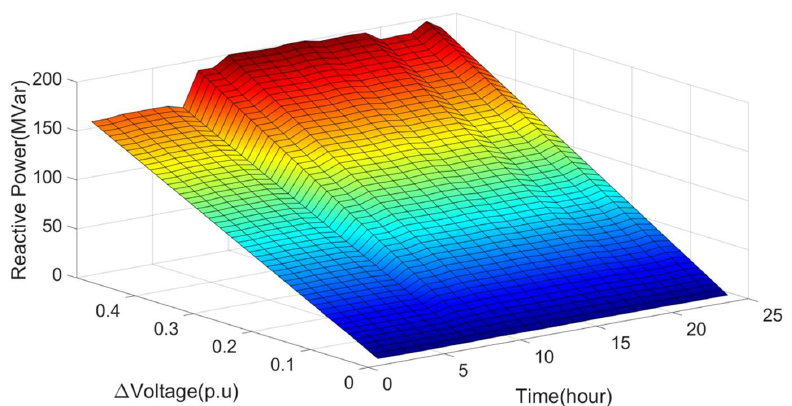
Figure 4. Surface fitting of the proposed method.